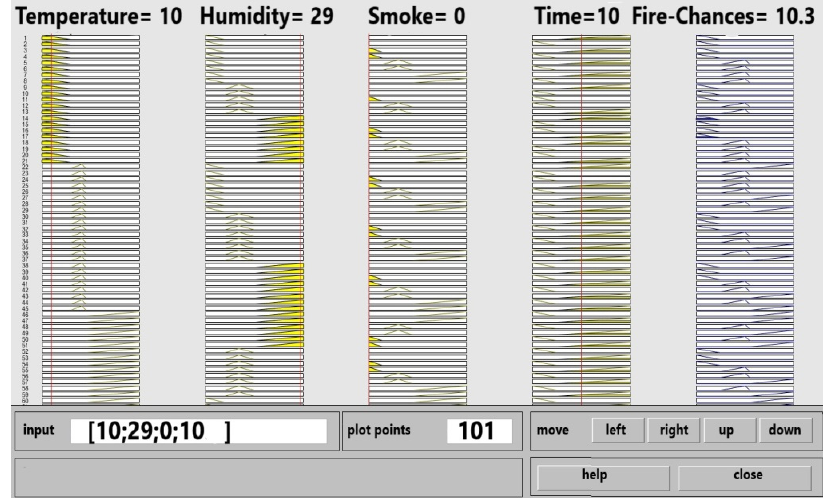
Figure 23. Fire Presence in MATLAB Rules Viewer.